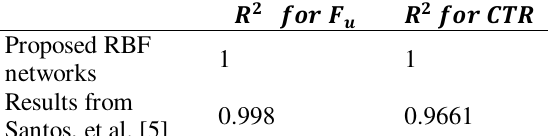
RBF neural network